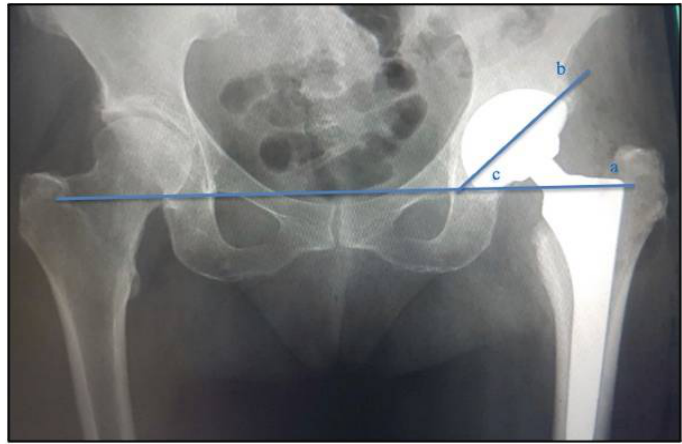
Figure 2. Acetabular component positioning angle measurement. (a)—line that touches the ischial tuberosities; (b)—line through the axis of the largest diameter formed by the projection of the metallic ring on the radiograph; (c)—acetabular angle.